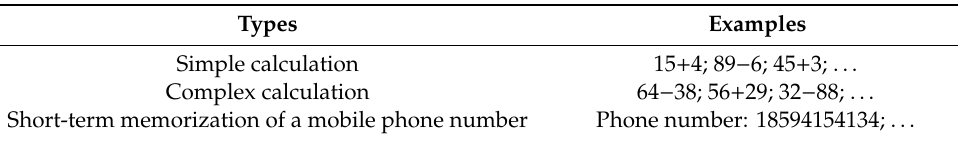
Table 1. Cognitive distraction tasks.